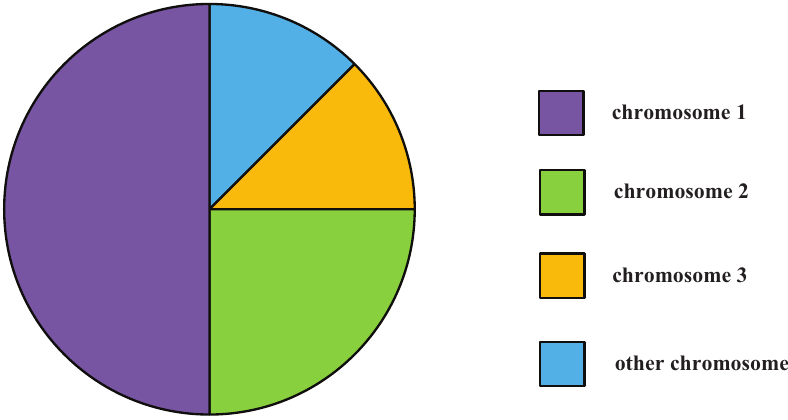
Figure 3. The process of select chromosomes in the GA-LNS algorithm.